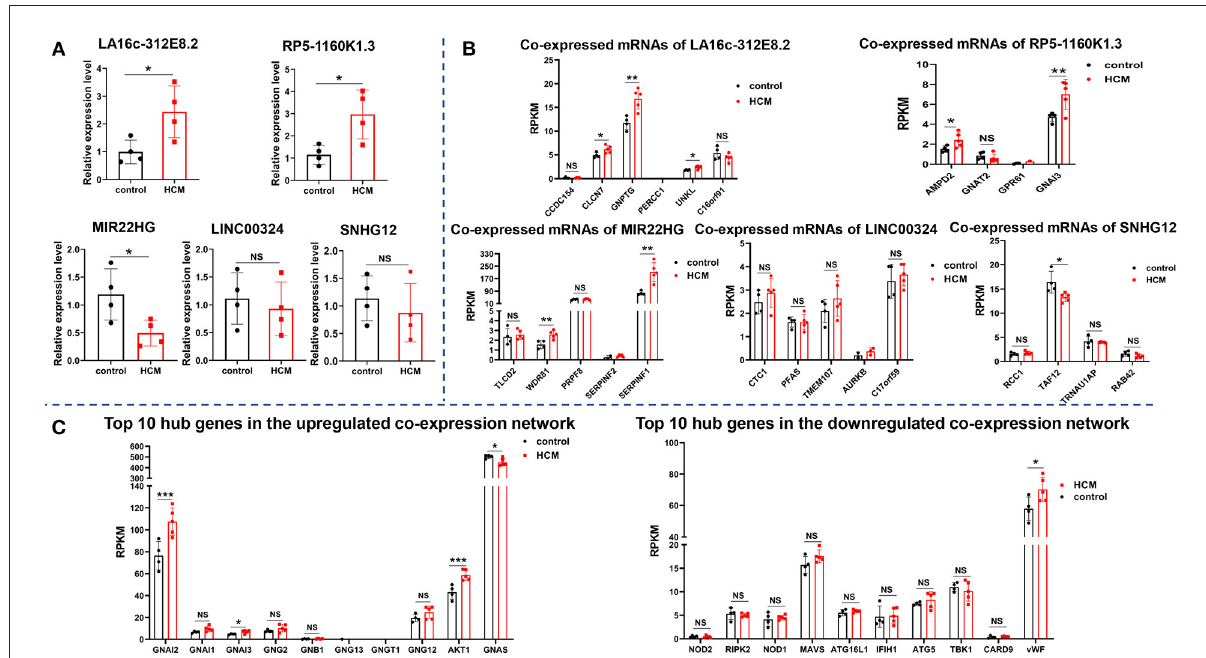
FIGURE8 Verification of crucial lncRNAs and mRNAs in HCM patients. (A) The expression of five crucial lncRNAs in plasma of HCM patients and the controls were measured by real-time qPCR. (B) The expression level of mRNAs (co-expressed with five crucial lncRNAs) in the verification dataset GSE89714. (C) The expression level of the top 10 hub genes of upregulated and downregulated PPI network in the verification dataset GSE89714. *** p <